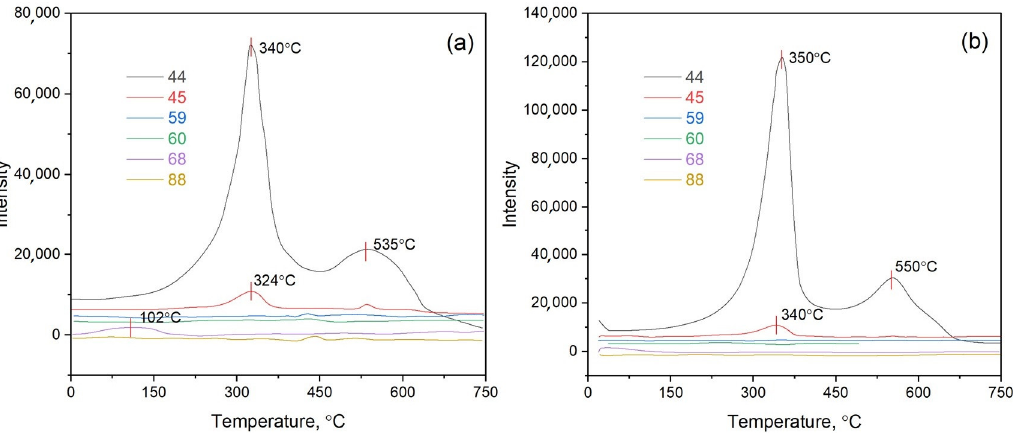
Figure 5. p-PGFPh:АА copolymers pyrolysis products chromatogram at initial ratios М 1 :М 2 , mol.%: Figure 5. p-PGFPh:AA copolymers pyrolysis products chromatogram at initial ratios M 1 :M 2 , mol.%: